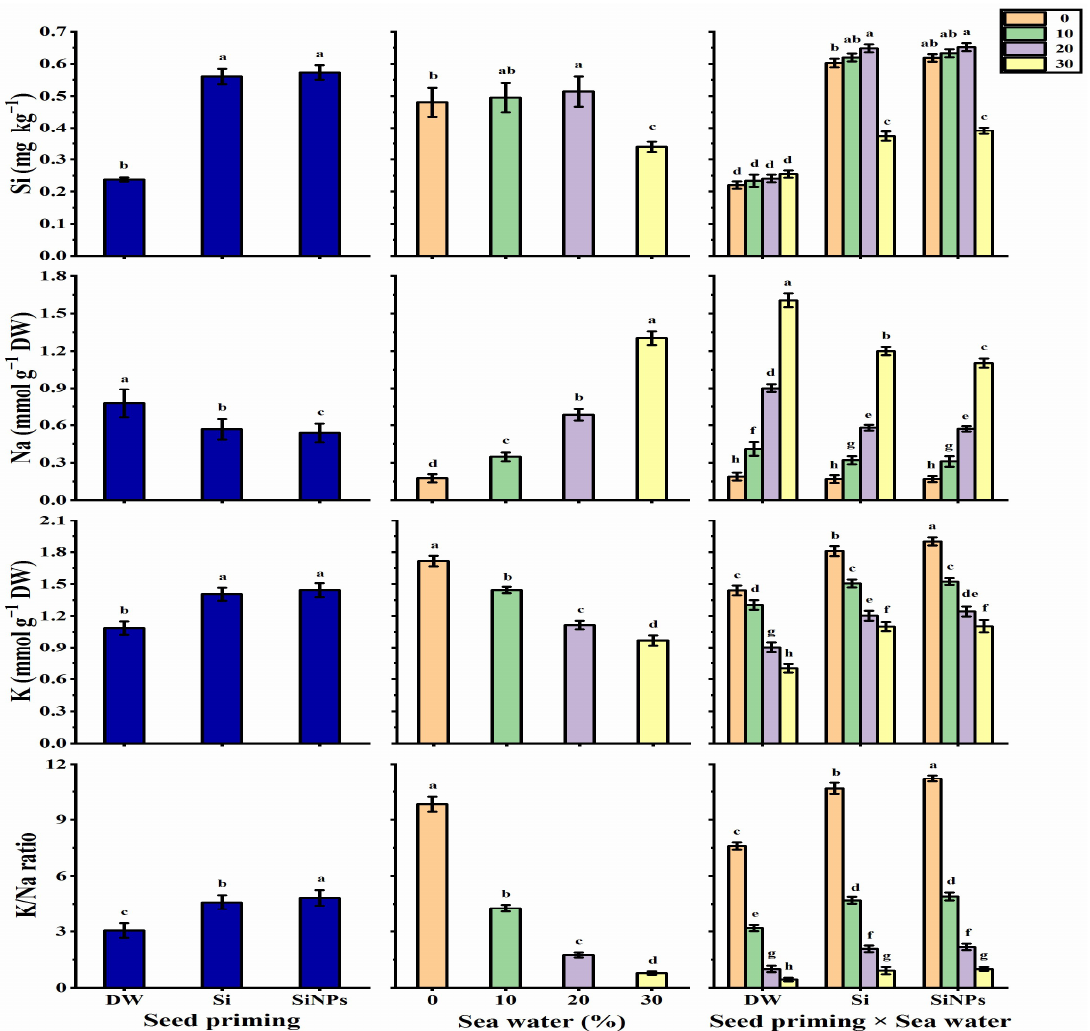
Figure 9. Effect of seed priming on Si (mg Kg − 1 ), Na (mmol g − 1 DW), K (mmol g − 1 DW) contents, and K/Na ratio (g) of Lathyrus odoratus leaves irrigated with seawater levels (0, 10, 20, and 30%). Data are mean value ± SE. Bars with different letters are significantly different at p ≤ 0.05 level.